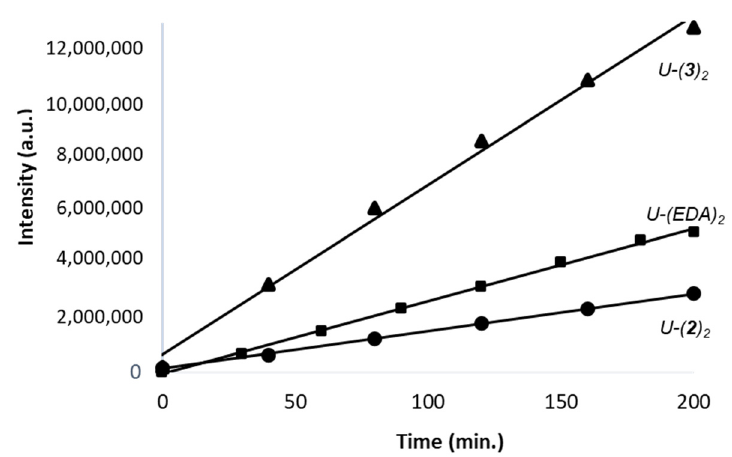
Figure 7. Comparison of the time-dependent formation of the bis-adduct for compounds 2 (circles) and 3 (triangles) in the presence of 5fU, vs. EDA (squares). Each compound (0.5 mM) was incubated with 5fU (0.5 mM) at 37 °C for 200 min in a methanol:water, ammonium formate buffer, 5 mM, pH 4.5 mixture (40:60, v:v). The reaction products were analyzed by HPLC-DAD and the surfaces of the pics corresponding to the bis-adducts were recorded at 254 nm.